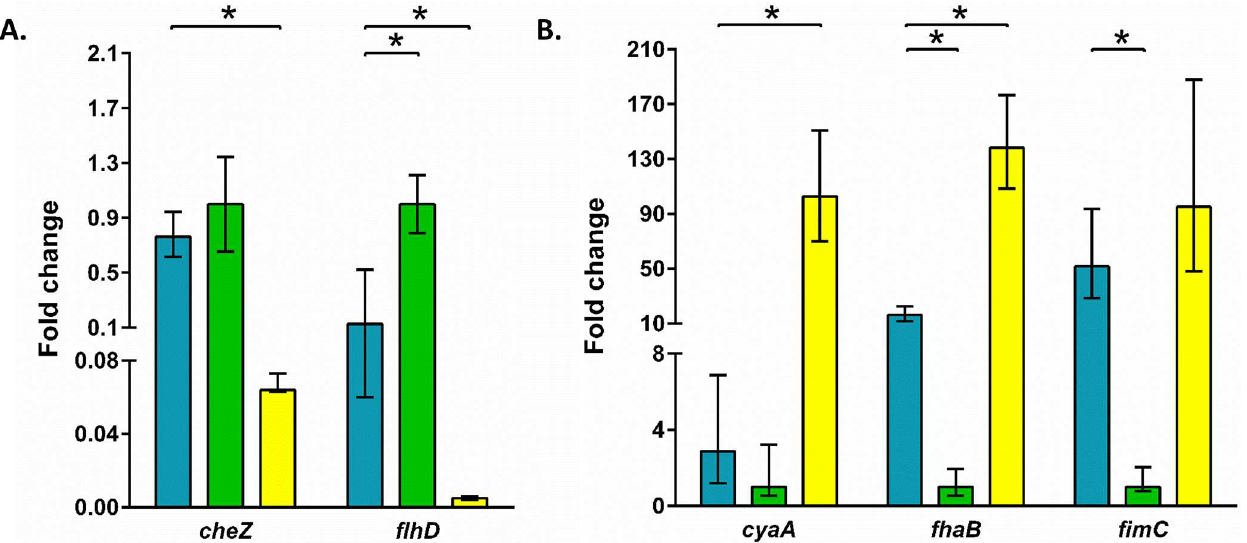
Fig 8. Gene expression of B . bronchiseptica in sori. Genes associated with Bvg - (A) and Bvg + (B) were selected, and the expression of those gene transcripts was comparedwith B . bronchiseptica isolatedfrom sori (blue) againstBvg - (green)and Bvg + (yellow)phase-locked mutants grown in liquidculture. Data represent the mean fold changein gene expressionlevels (with standard deviations) relativeto the Bvg - phase- locked mutant RB54 from three independentexperiments. An asterisk ( * ) indicatessignificantly different expressionlevels ( p -value (cid:20) 0.05) in pair-wisecomparisons. For further details, pleasesee S2 Data.